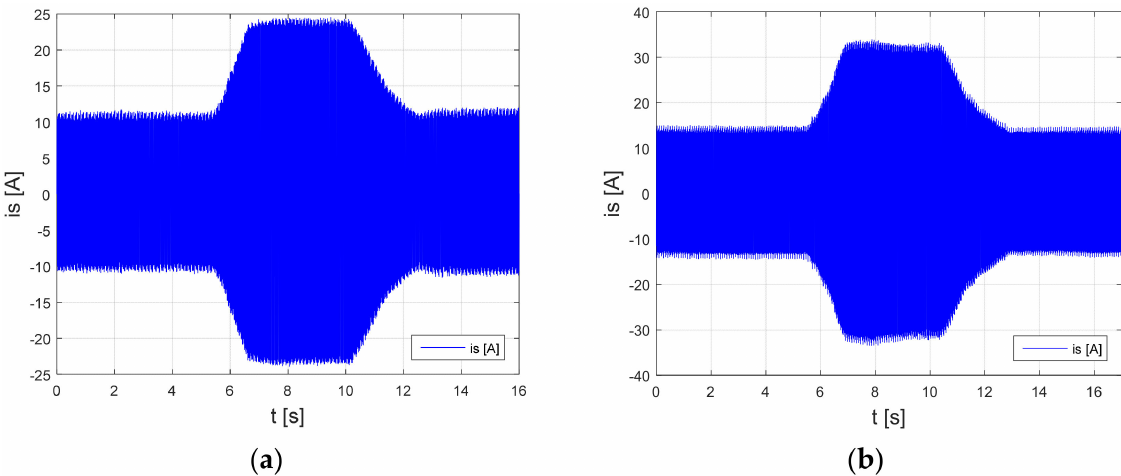
Figure 15. Waveforms of the input current of the converter for the speed of: ( a ) 1000 rpm; ( b ) 1500